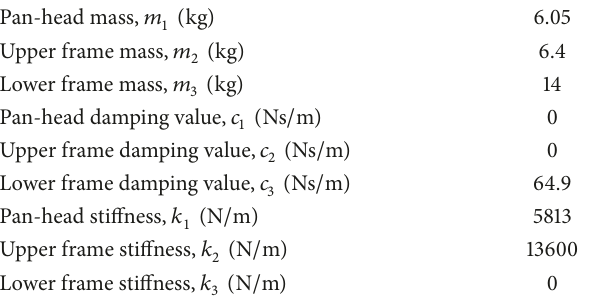
Table 8: Parameters of the sss400+